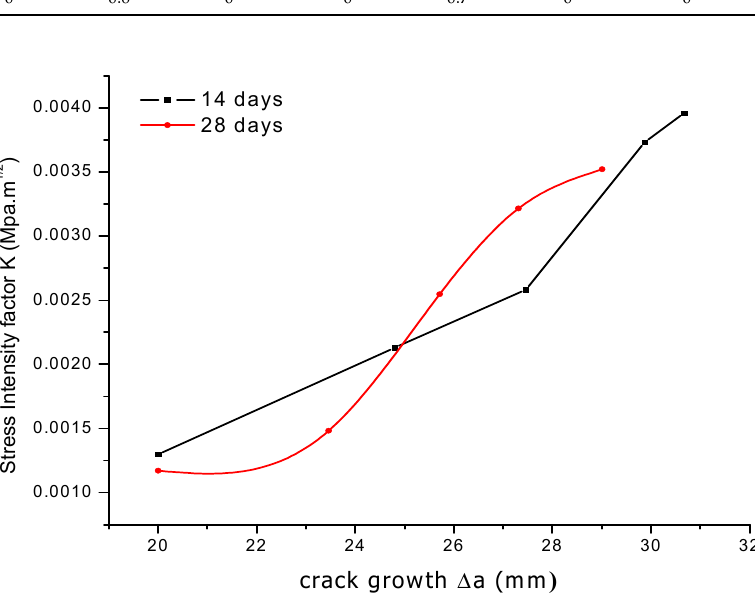
Figure 8. Fracture toughness of the 5 wt% stabilization after curing for 14 and 28 days.